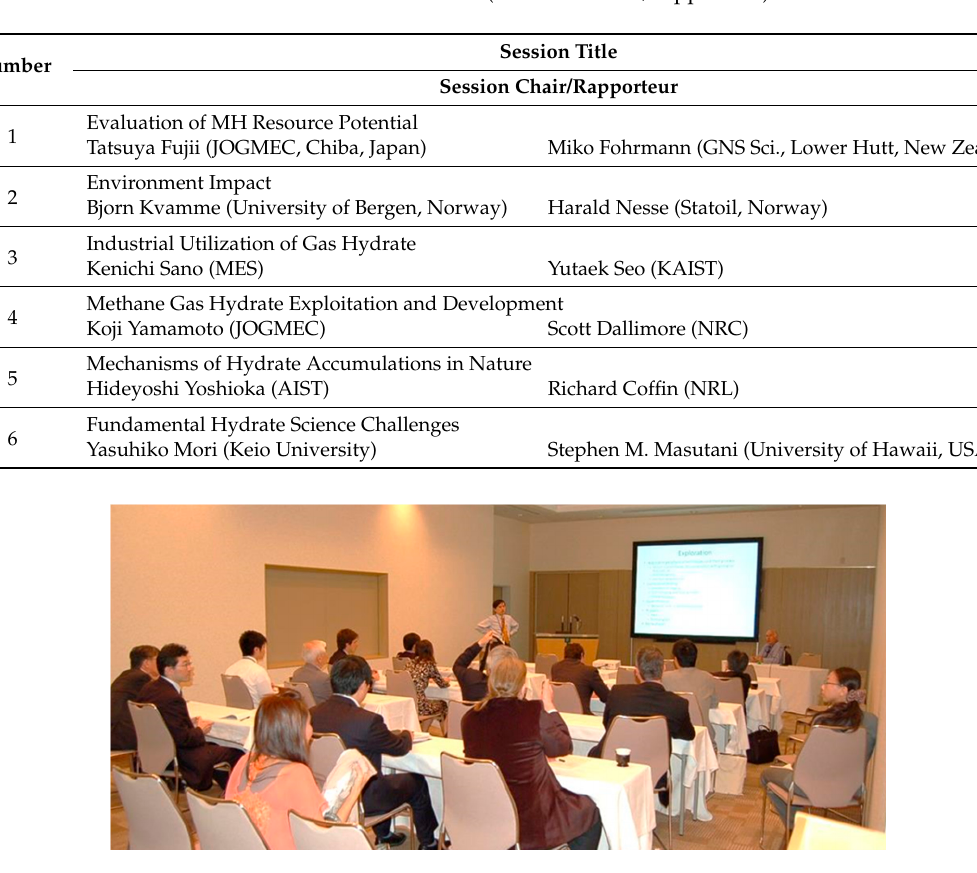
Table 9. Breakout sessions (title and chairs/rapporteur).